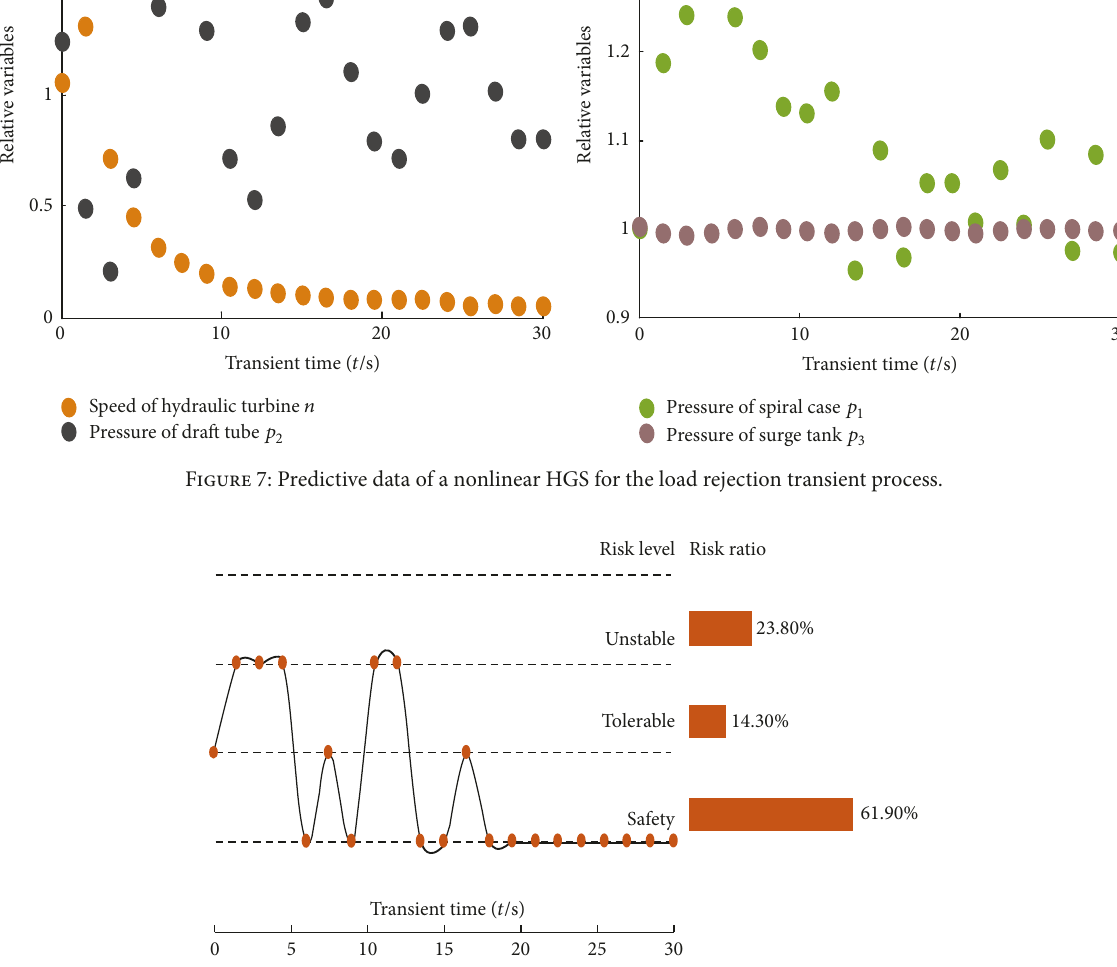
Figure 8. It is demonstrated that the probabilities of Risk, Unstable, Tolerable, and Safety are, respectively, 0, 23.8%, 14.3%, and 61.9%. In other words, the HGS keeps stable for more than half the transient time; meanwhile, there is no